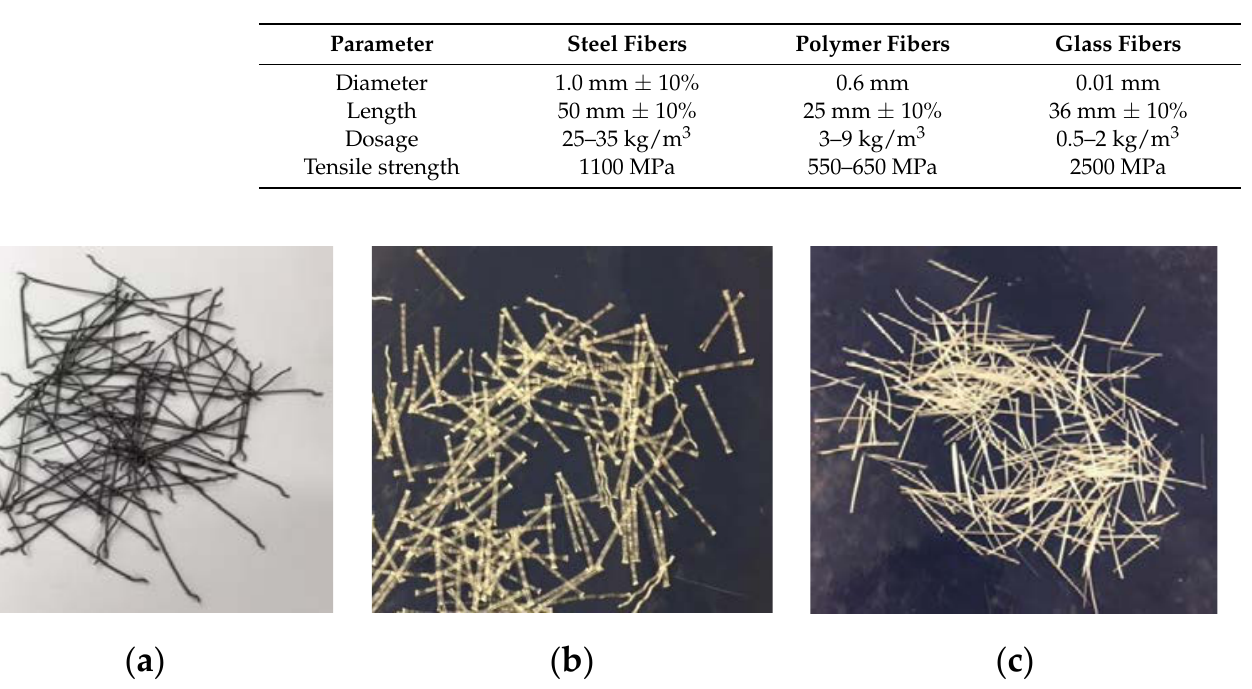
Table 5. Parameters of fibers.